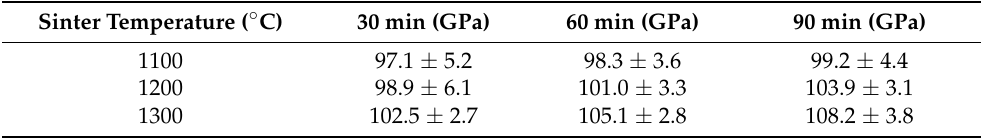
Table 5. Elastic moduli of the sintered titanium